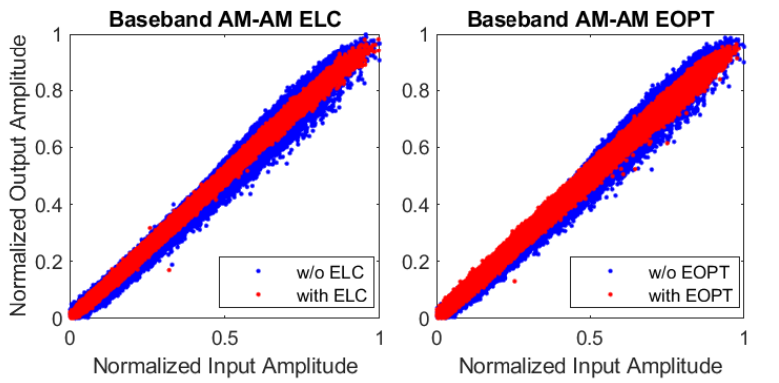
Figure 10. AM–AM plot of the normalized baseband input and ET PA output.